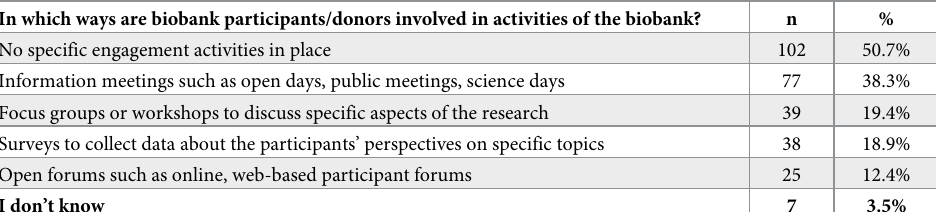
Table 8. Biobank participants’ involvement in activities of the biobank.